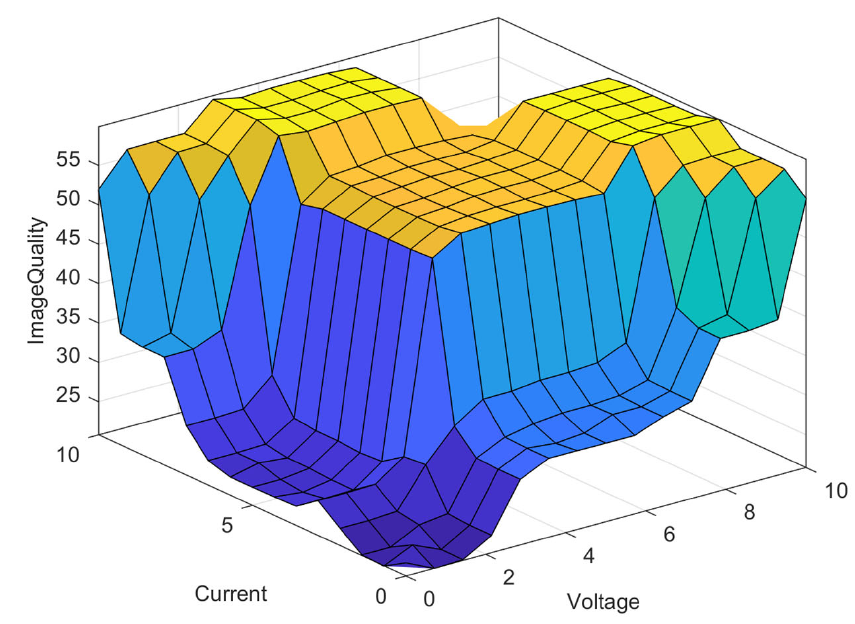
Figure 8. View of the model surface as a function of current and voltage.